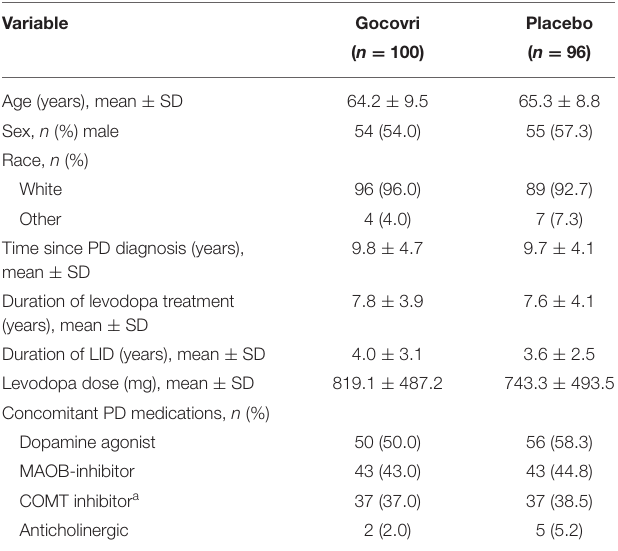
TABLE 1 | Baseline demographic and PD characteristics, by treatment group (mITT population) (21).